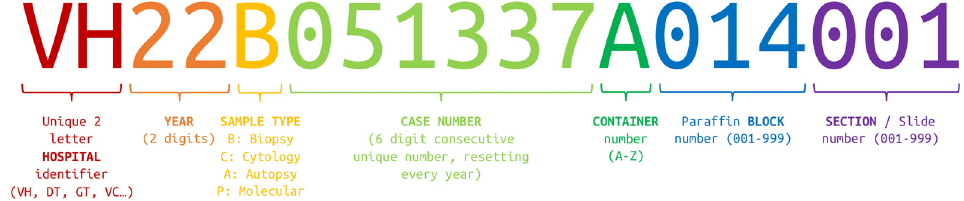
Figure 9. Barcode